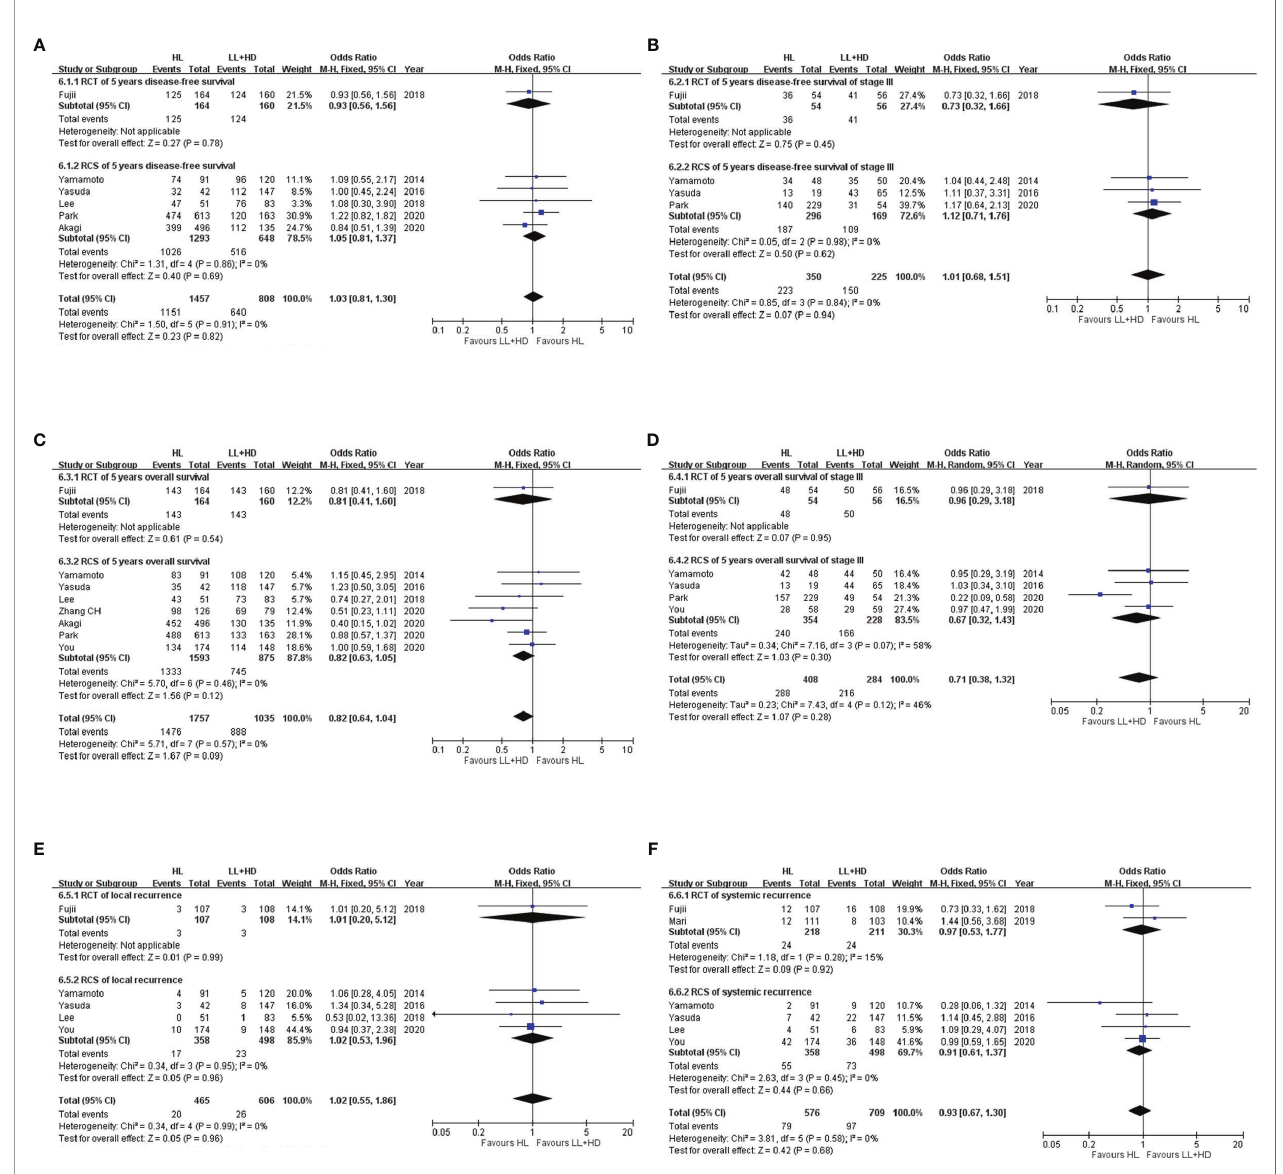
FIGURE 6 | Meta-analysis of survival and recurrence. (A) Forest plot of DFS (any stage) following HL versus LL+HD. (B) Forest plot of DFS (stage III) following HL versus LL+HD. (C) Forest plot of OS (any stage) following HL versus LL+HD. (D) Forest plot of OS (stage III) following HL versus LL+HD. (E) Forest plot of local recurrence following HL versus LL+HD. (F) Forest plot of systemic recurrence following HL versus LL+HD. HL, high ligation of the inferior mesenteric artery; LL+HD, low ligation of the inferior mesenteric artery plus high dissection of lymph nodes; DFS, disease-free survival; OS, overall